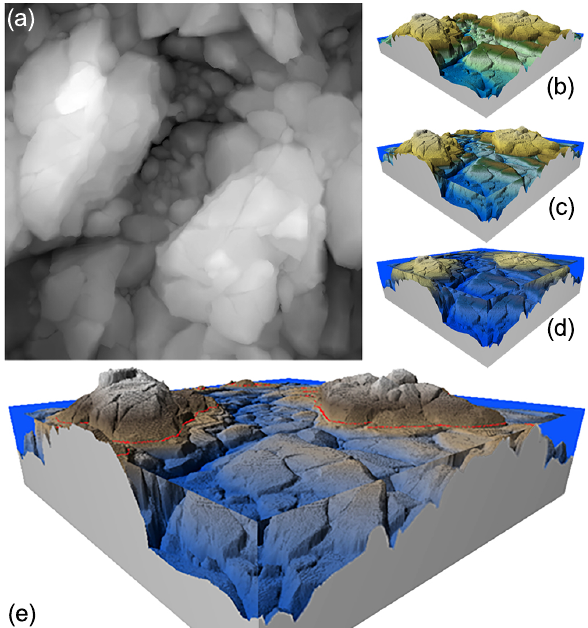
Figure 16. Example of the water level simulation in a 3D surface render on a virtual terrain: (a) synthetic heightmap; (b) standard 3D render with low water level and (c) and (d) simulations with rising water levels; (e) illustrates a close-up view with another ground color Figure 15. Illustration of creating a custom colormap to render a virtual heightmap (left) ; It is worth noting the paradigm shift in the interpretation of information.